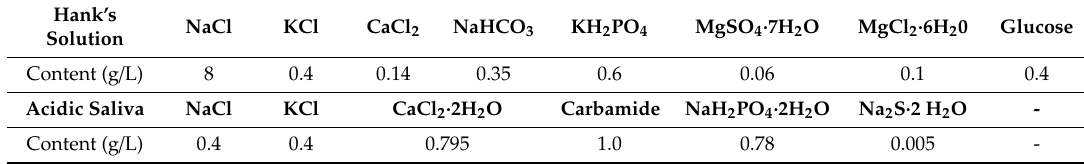
Table 3. The components of Hank’s solution and acidic